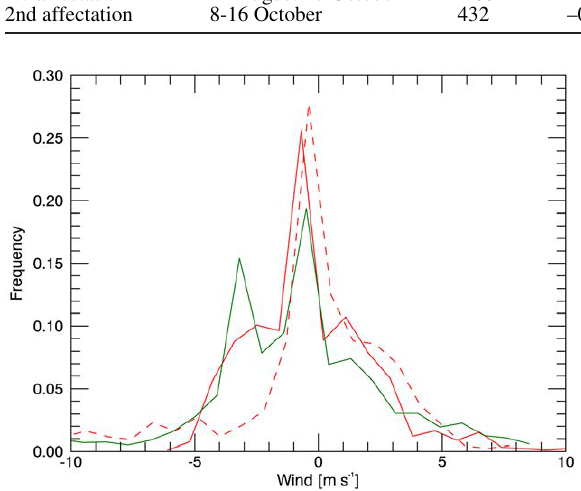
Fig. 3. – Histograms of the wind component perpendicular to the coast corresponding to the first affectation period (solid red line), the intermediate period (green line) and the second affectation pe- riod (dashed red line). Negative values indicate landward winds and positive values indicate